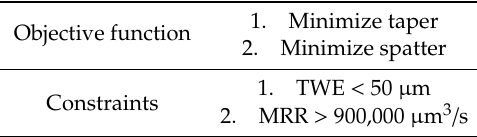
Table 3. Objective functions and constraints for the